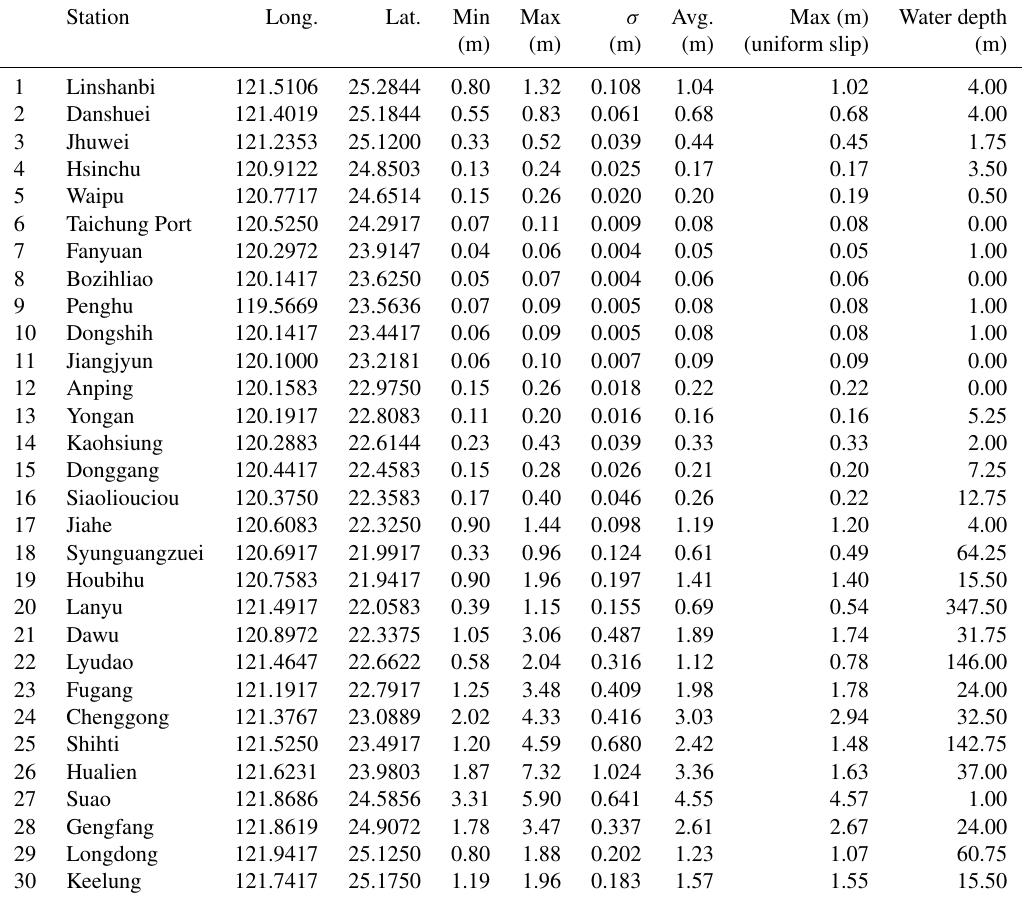
Table 1. The maximum, minimum and average wave heights with their standard deviations for the PTA probability distributions (in meters) with the maximum wave heights from the uniform slip model. The water depths at the stations in the computational mesh are also